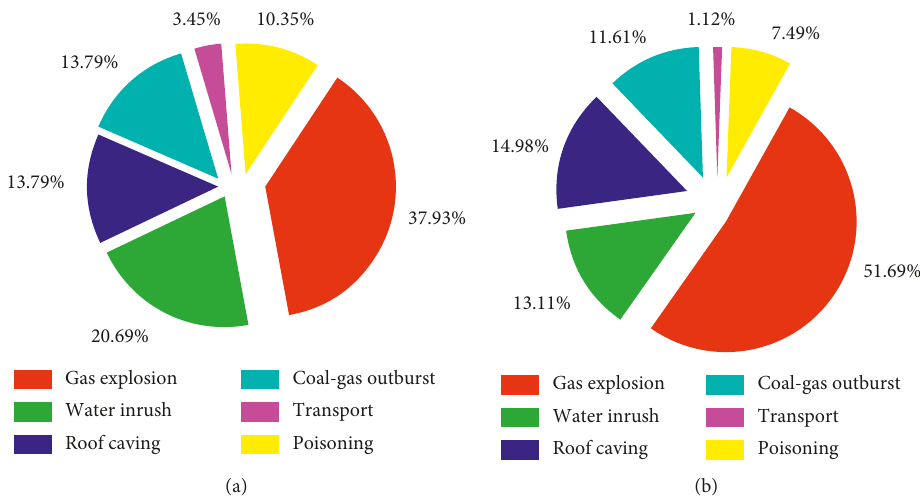
Figure 1: Large accidents in China’s coal mines in 2016 [1]. (a) Percentage of different structure types of large accidents. (b) Percentage of deaths of different structure types of large